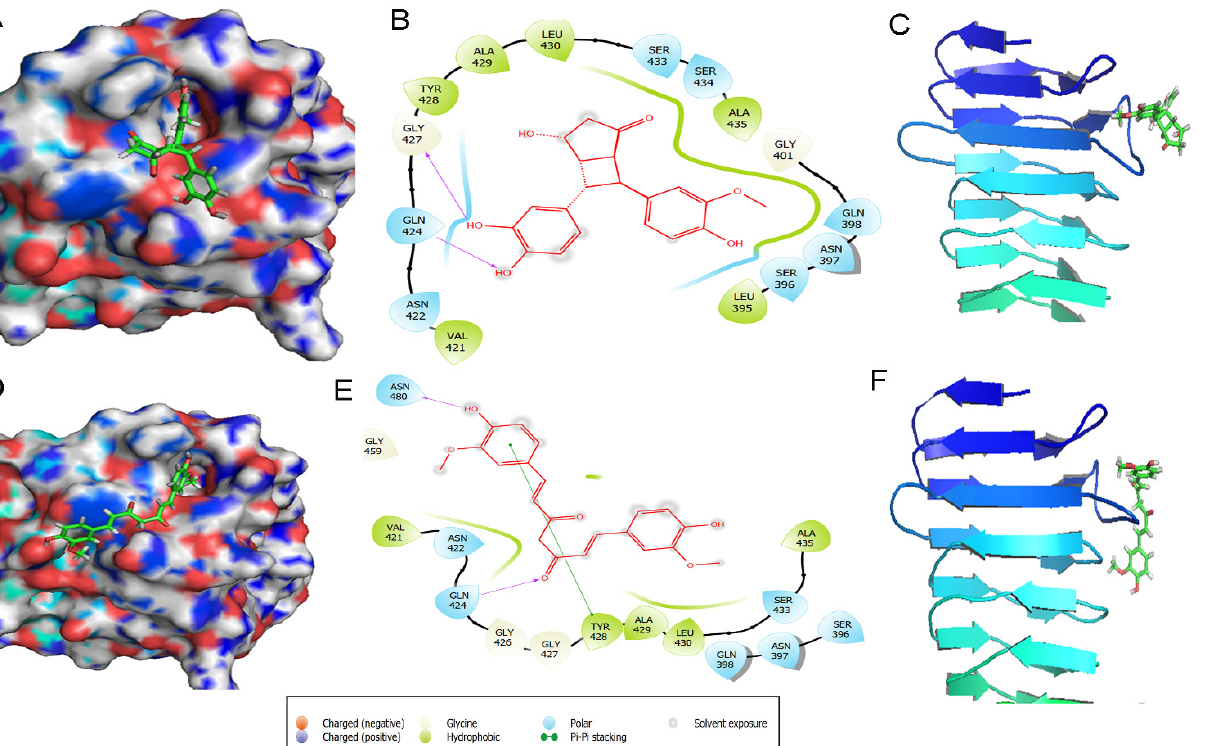
Figure 4. p55 and ligand Cyclobutyl cyclopentadine and Curcumin interaction. Protein-ligand in- teraction diagrams for Cyclobutyl cyclopentadiene: 3D crystallized structure, secondary structure,